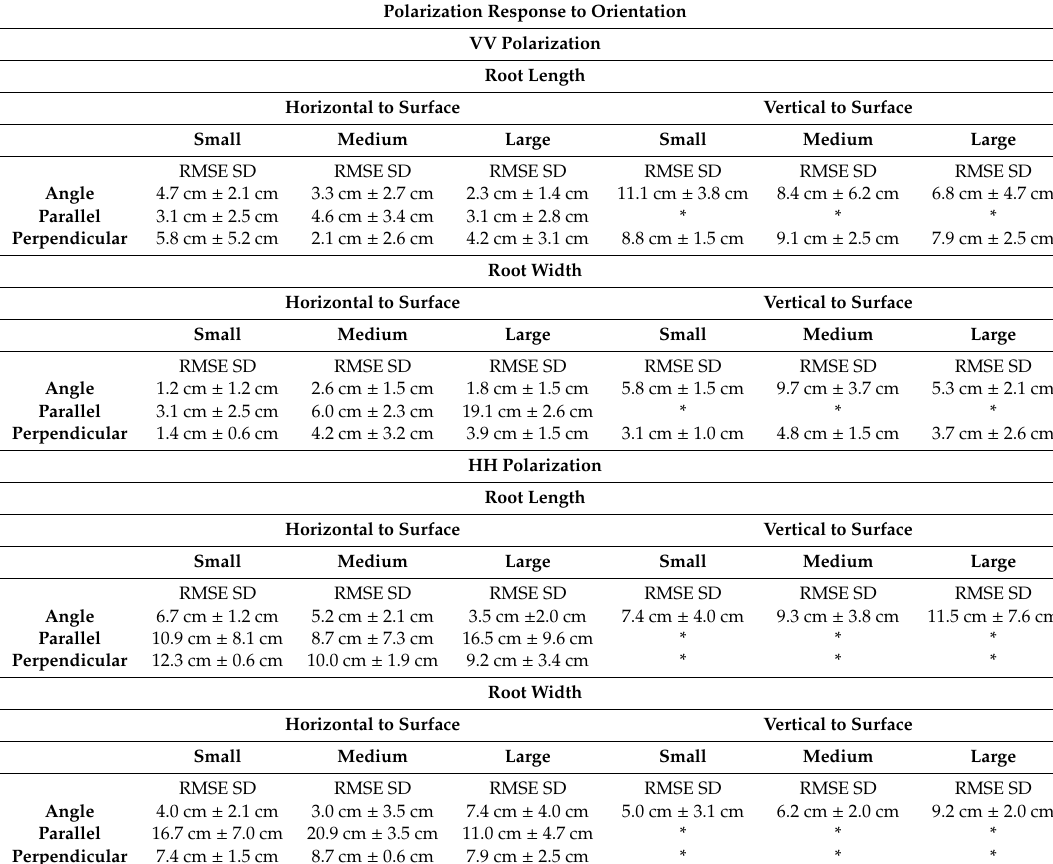
Table 3. Results of accuracy analysis utilizing root mean squared error (RMSE) and standard deviation (SD) for identifying Polarization response to orientation across three root size classes. Asterisks signify no data available for that parameter due to the inability to segment root features from